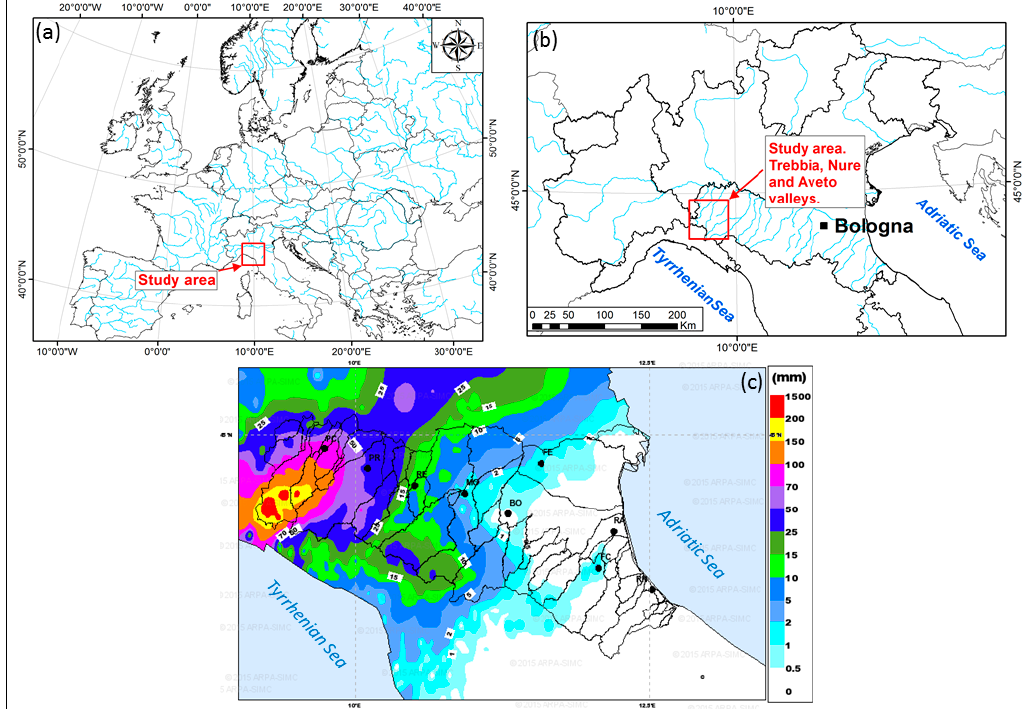
Figure 1. Location map of the study area ( a , b ) and the cumulative rainfall ( c ) from 23:00 local time on 13 September to 05:00 on 14 September, on the major catchment areas of the Emilia-Romagna Region. According to the rainfall data recorded in the meteorological stations of the ARPAE-SIMC regional network.